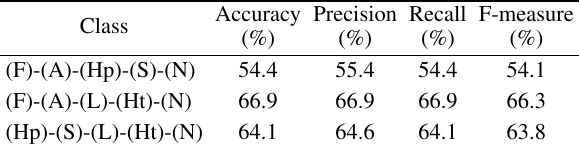
Table 5 Accuracy, Precision, Recall, and F-measure of the 5-class